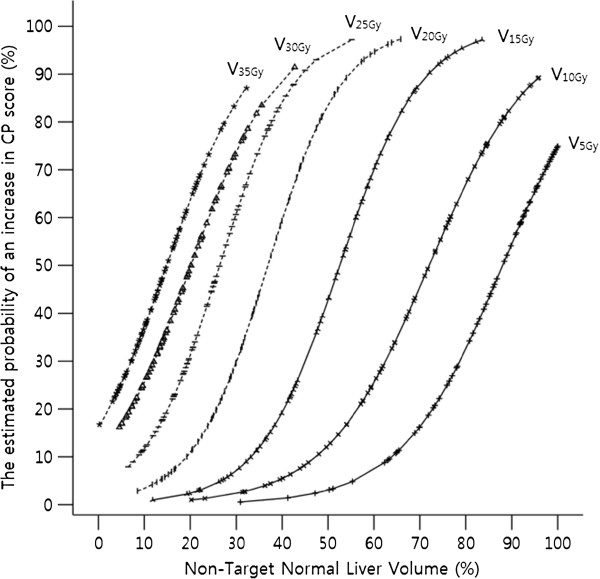
The estimated probability of an increase in CP score for V5Gy, V10Gy, V15Gy, V20Gy, V25Gy, V30Gy, and V35Gy.